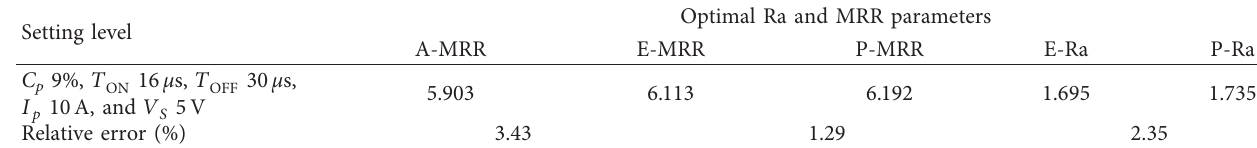
Table 10: Final optimization results of PMEDM process in different machining regimes. Setting